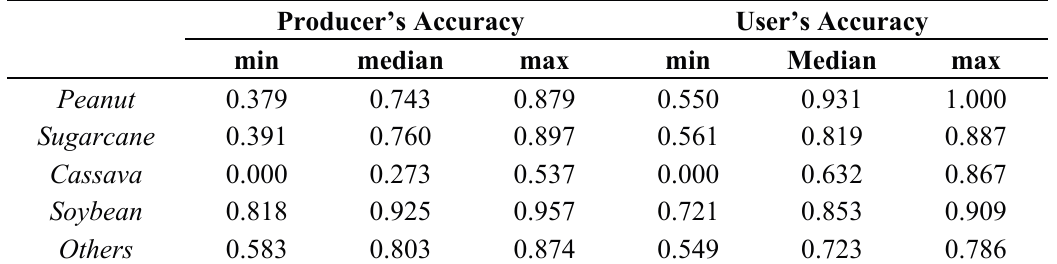
Table 6. Class specific producer and user accuracies amongst the 1025 different segmentations and classifications (out-of-bag (OOB) results combining samples A and